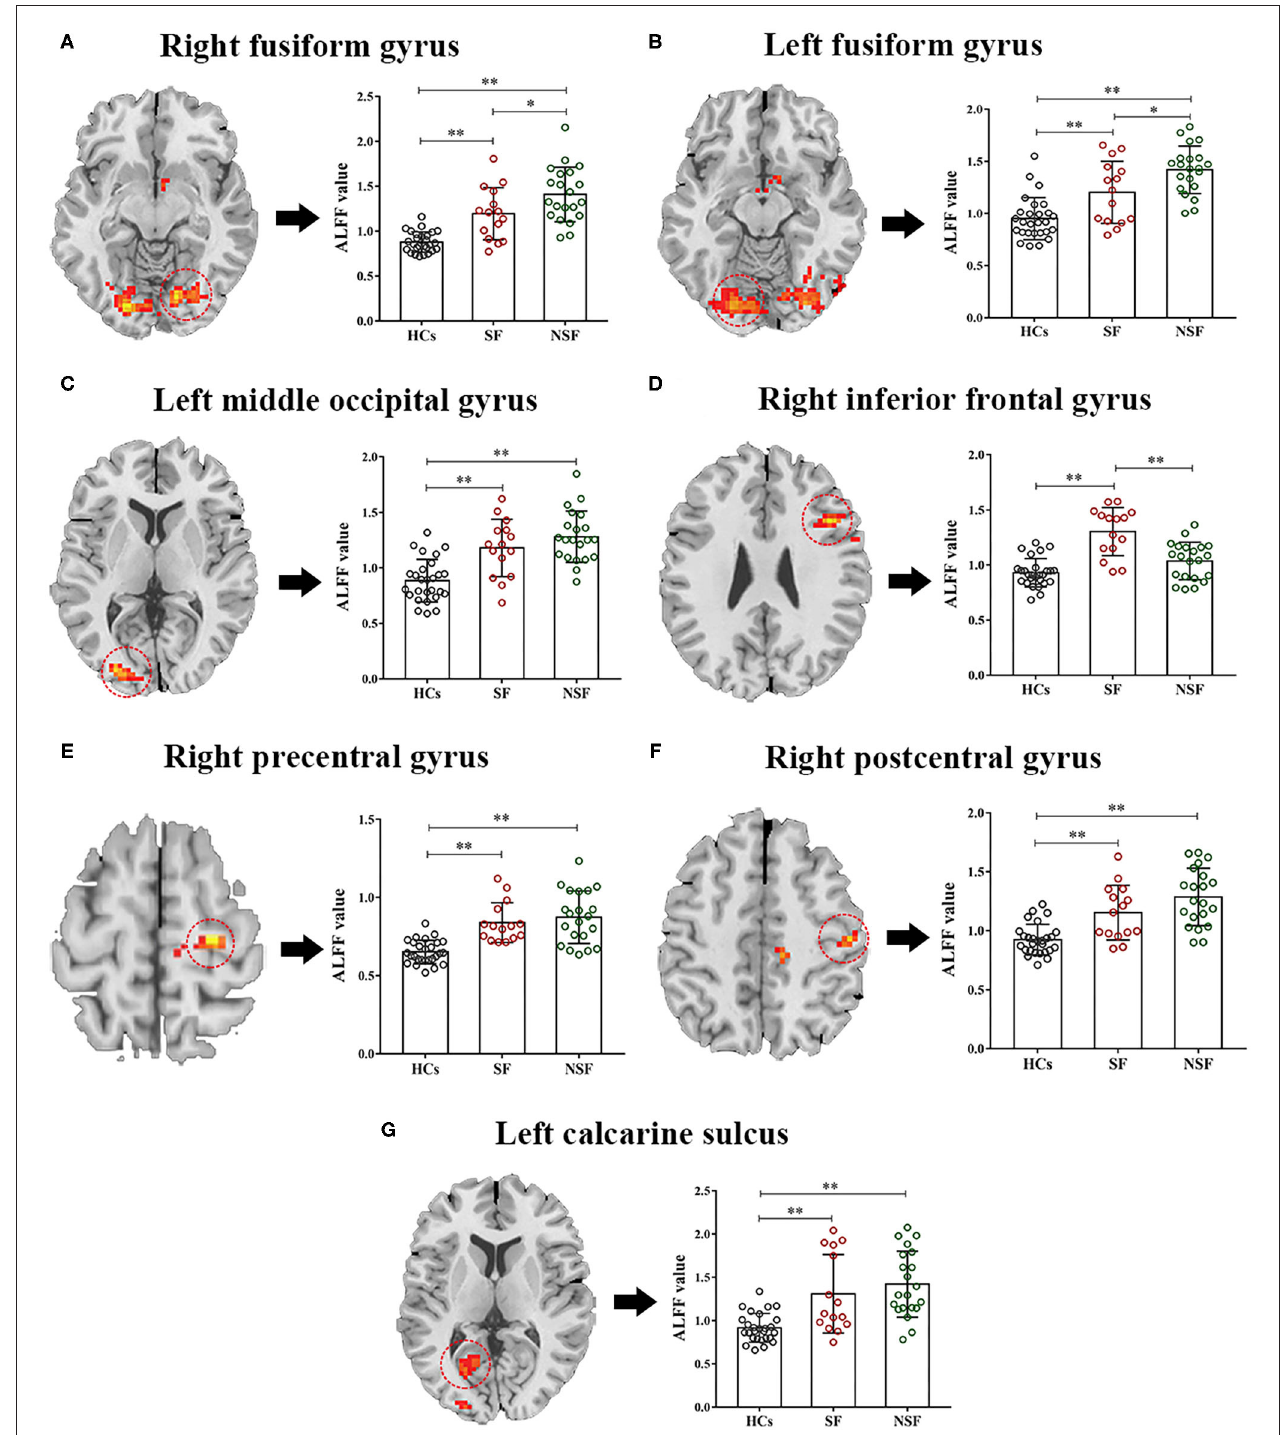
FIGURE 2 | Pairwise comparison of ALFF in the seven brain regions. One-way ANOVA was used to compare the ALFF values of the three groups, and Bonferroni correction of post-hoc analysis was done at the same time in the significant brain regions (A–G) . ** p < 0.01, * p < 0.05 after Bonferroni correction of post-hoc analysis. ALFF, the amplitude of low-frequency fluctuation; SF, seizure free; NSF, non-seizure free; HCs, healthy